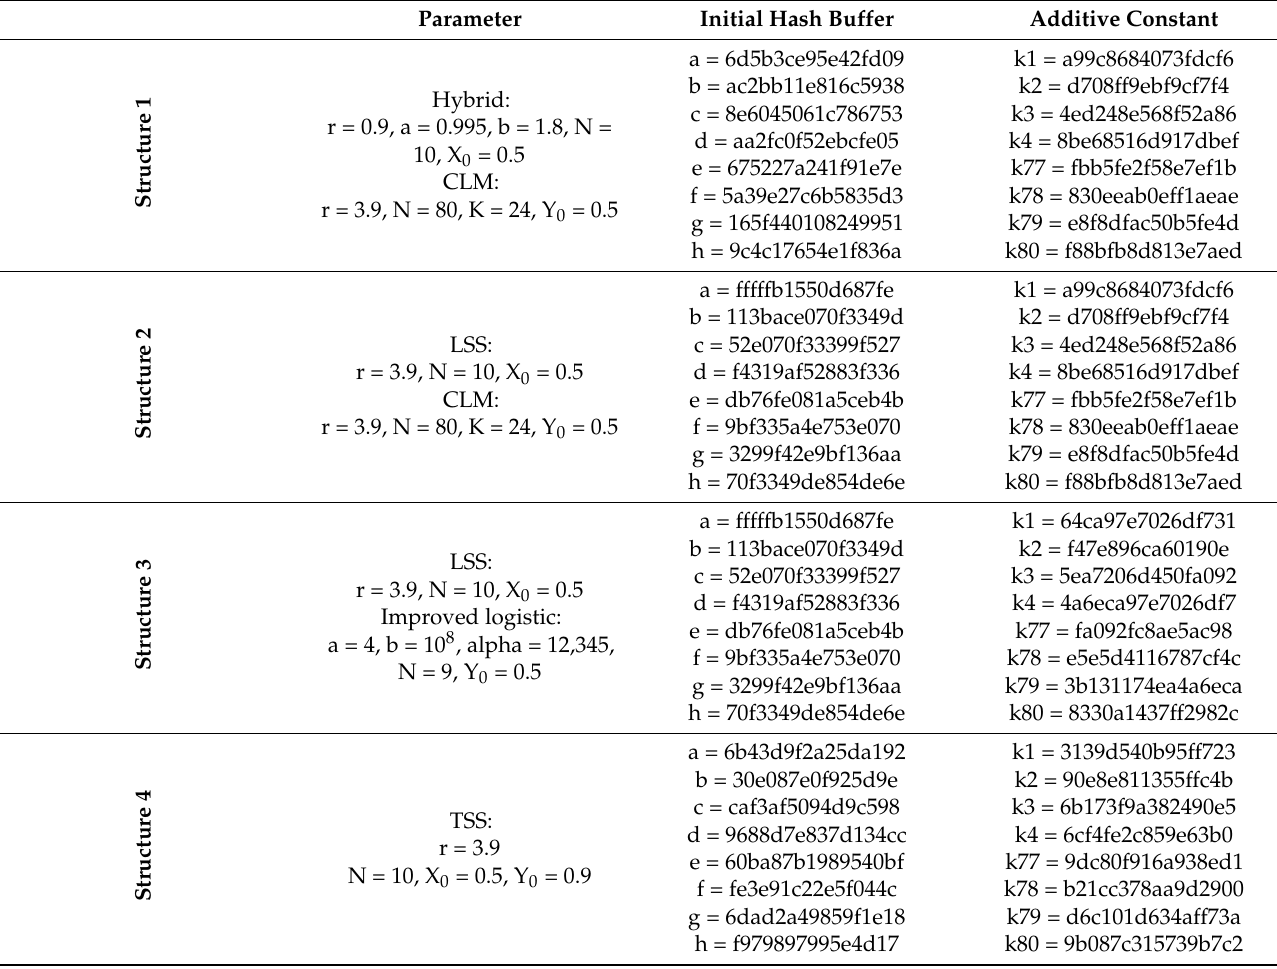
Table 3. Lookup table for initializing hash buffer and additive constant.